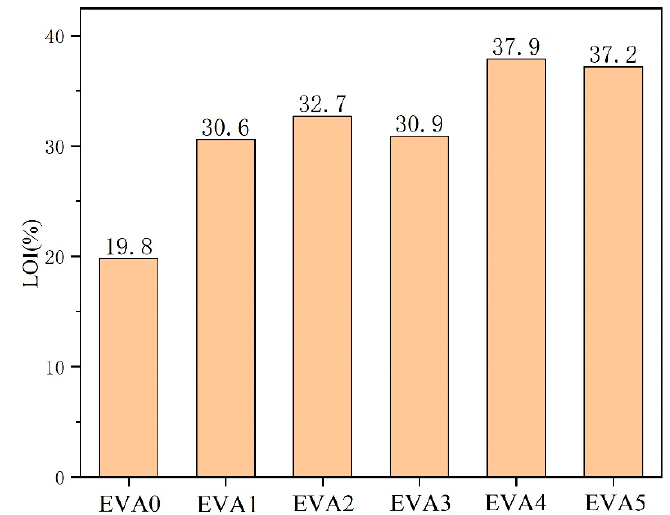
Figure 6. Limiting oxygen index (LOI) results of neat EVA and EVA/MH composites.